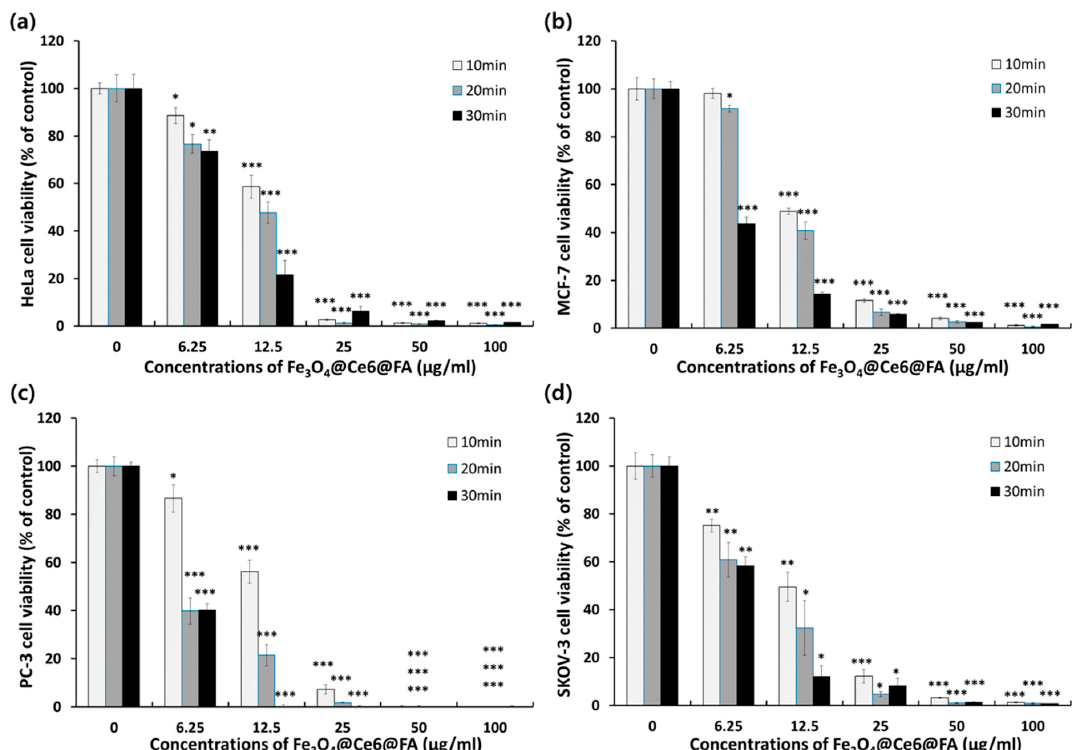
Figure 5. Photodynamic anticancer activities of the FCF NPs in various cancer cells. Phototoxicity of ( a ) HeLa (cervical adenocarcinoma), ( b ) MCF-7 (breast adenocarcinoma), ( c ) PC-3 (prostate adenocarcinoma), and ( d ) SKOV-3 (ovary adenocarcinoma) cells as a function of the duration of exposure to light. Data for photodynamic anticancer activity are expressed as a mean ± S.D. (n = 4), and statistical significance, as analyzed by Student’s t -tests, was set at p < 0.005 (* p < 0.005, ** p < 0.0005 vs. control).